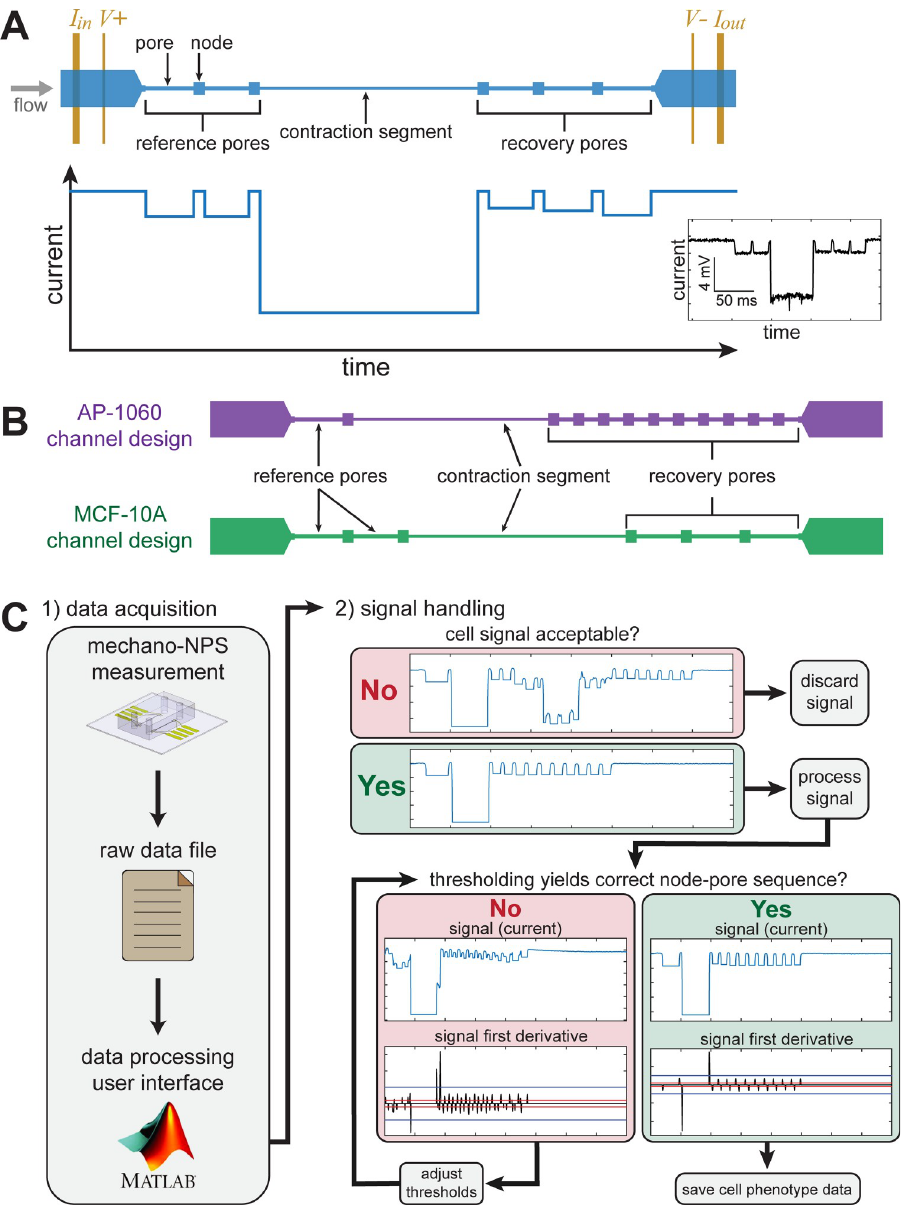
Fig 1. Overview of mechano-node-pore sensing (mechano-NPS) operating principles, device design, and data processing pipeline. (A) Top-down schematic view of a mechano-NPS device (top), with corresponding expected electric current pulse (bottom) caused by a single cell transiting the microfluidic channel. A potential is applied across the channel, causing a drop in measured current when a cell enters a narrow segment of the microchannel (pore). Inset: An actual current pulse caused by an MCF-10A cell traversing the channel. (B) Top-down schematic views of mechano-NPS channel designs used in this work for screening AP-1060 and MCF-10A cells. (C) Flow of user input to the data processing analysis software. The user must identify valid signals corresponding to cell measurements and exclude non-valid pulses. Subsequently, the user must set processing thresholds to the appropriate levels for each valid